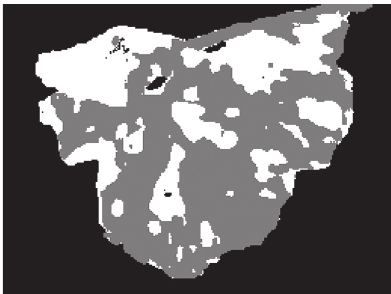
Figure 12: Blue nuclei.